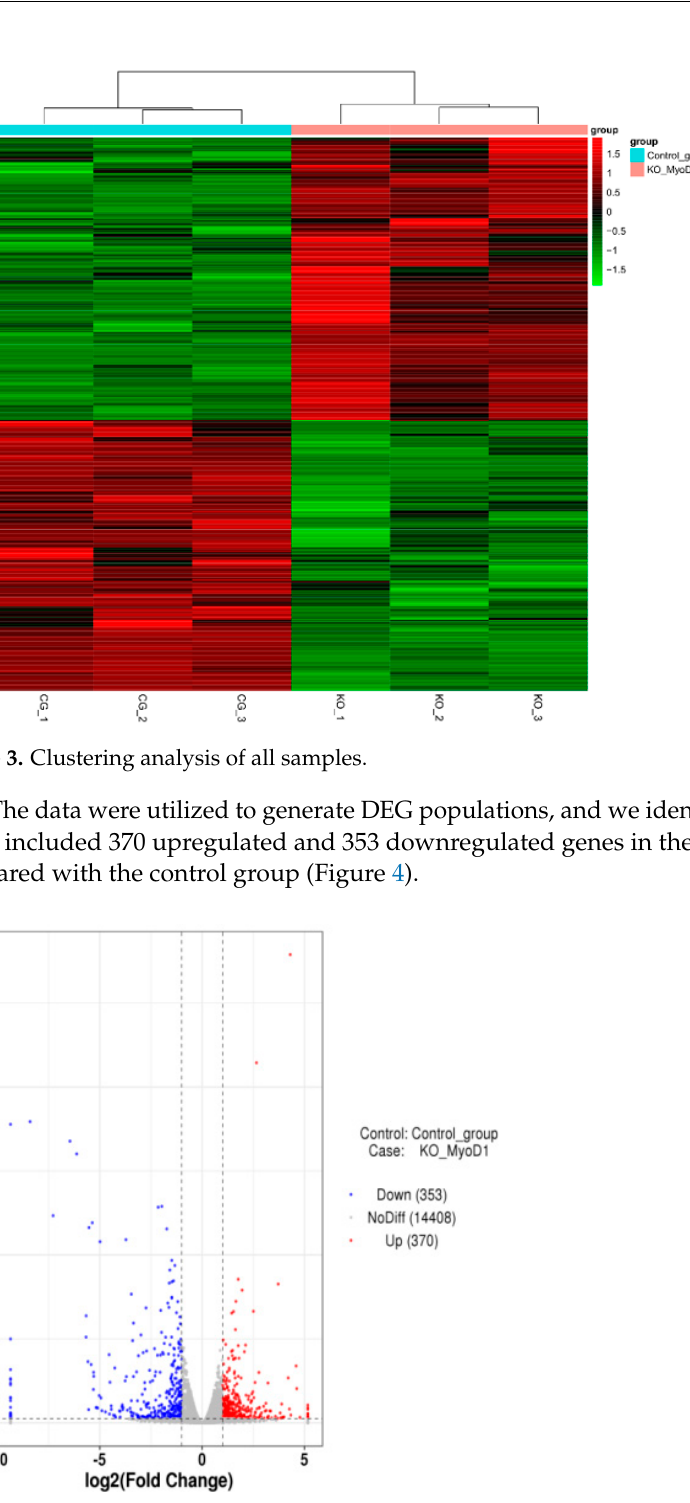
upregulated; blue, downregulated.